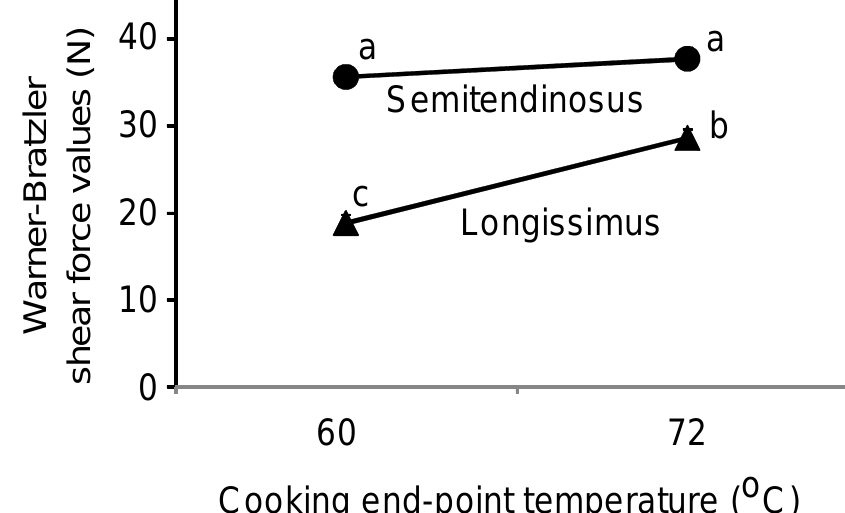
Figure 1. Effects of cooking end-point temperature and muscle position on Warner-Bratzler shear force values. Triangles and circles mean Longissimus and Semitendinosus muscles, respectively. Values are expressed as least squares means  SEM. a,b,c Values with different letters are different at